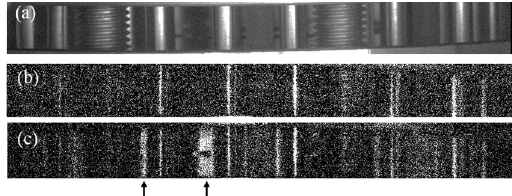
FIG. 23. CCD images of the central cell of the HPBG-d3 structure of (a) ambient light view showing sapphire, copper and clamping rods, (b) background light illuminating the cooper rods on a low gradient shot without breakdown, and (c) light emission on the sapphire rods (indicated by arrows) at E G > 5 . 7 MV = m. This view is similar to the view shown in Fig. 15(b).